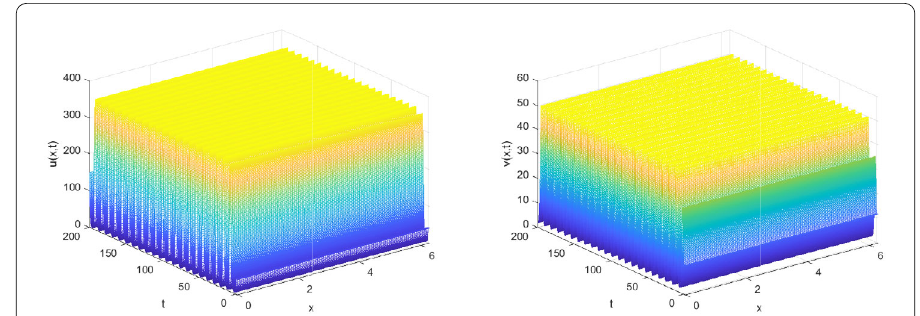
Figure 10 τ = 2, β = 0.16 and the initial condition is (40.87,11.68). The system produces periodic solutions